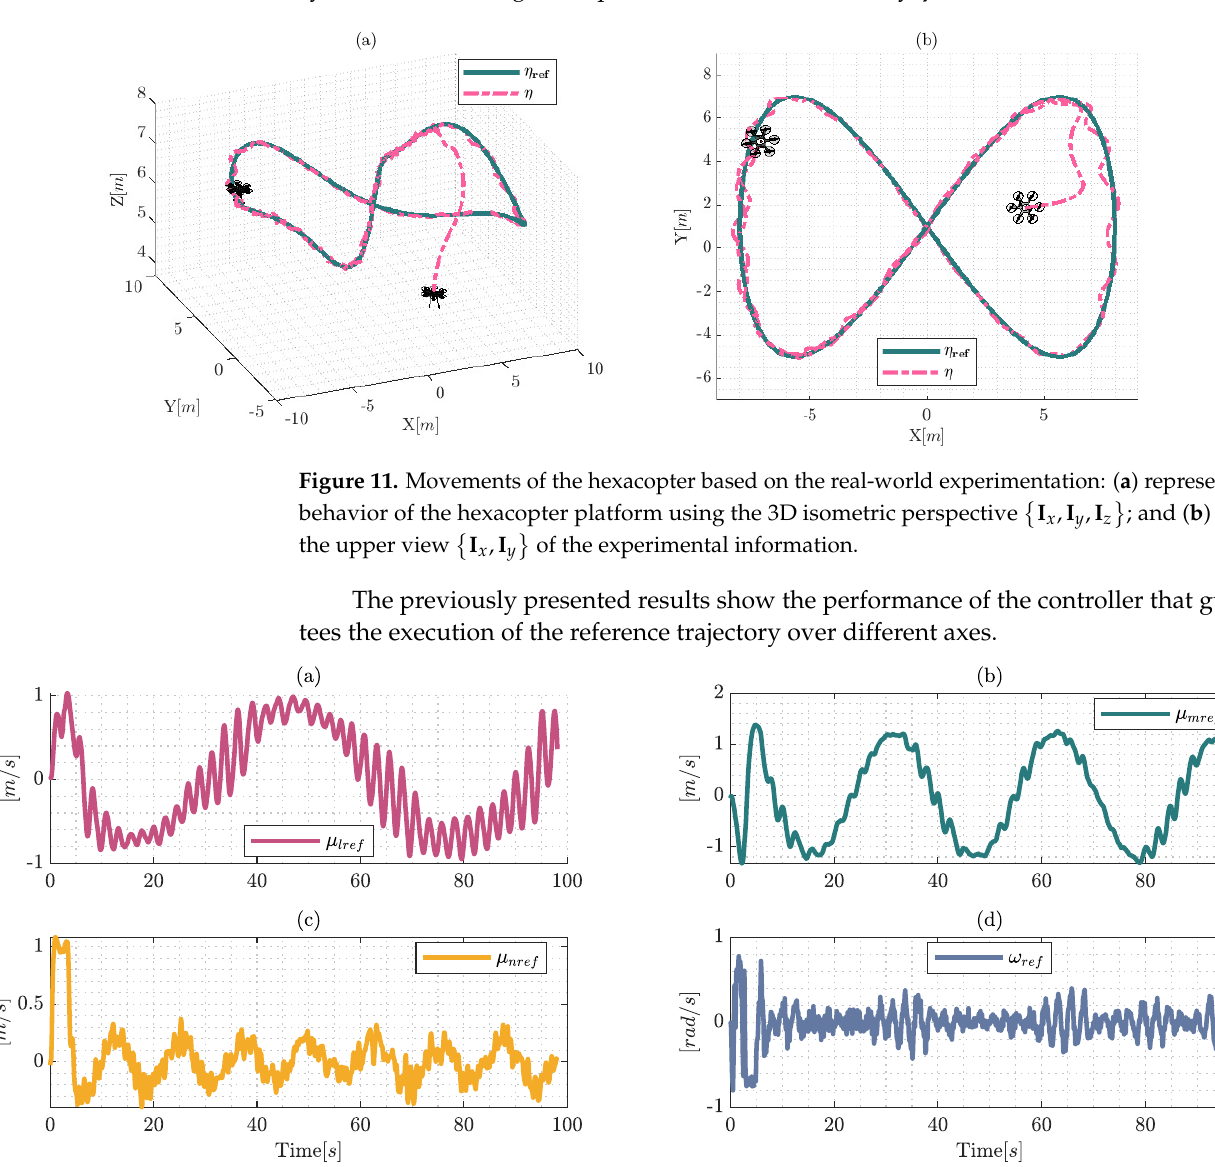
Figure 12. Control signals generated by the proposed control during the real-world experiment, where ( a ) represents the control velocity over the axis { I x } ; ( b ) describes the evolution of velocity in finally ( c ) and ( d ) represent the evolution of the upper and angular control velocity,